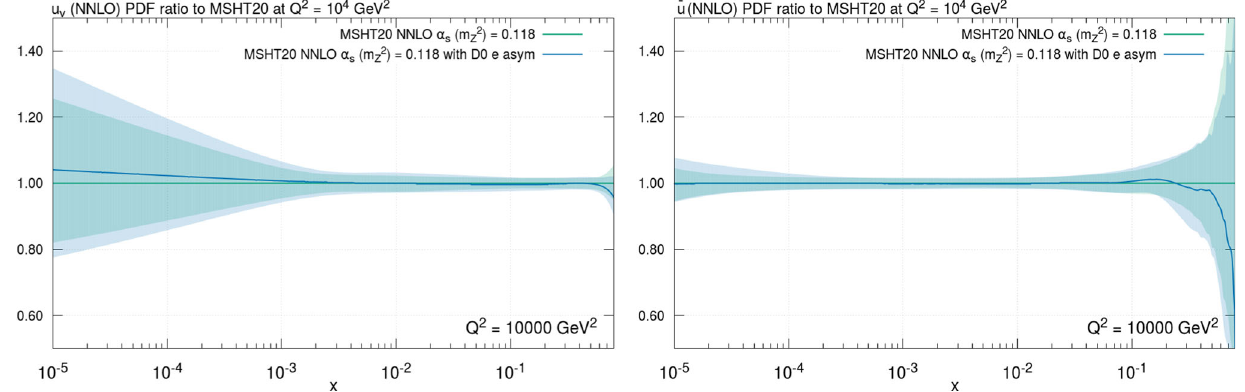
Fig. 57 (Left) d V PDF and (right) ¯ d PDF ratios to the MSHT20 default at Q 2 = 10 4 GeV 2 at NNLO showing the effect of including the DØ data as an electron asymmetry rather than the W asymmetry